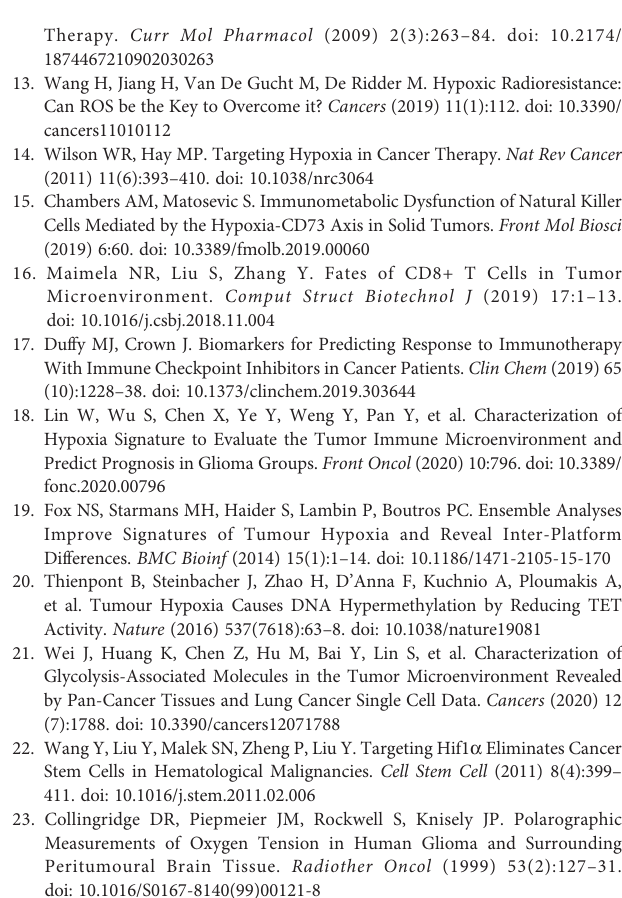
Supplementary Figure 1 | Association of hypoxia-associated genes with characteristics and survival in different subgroups of